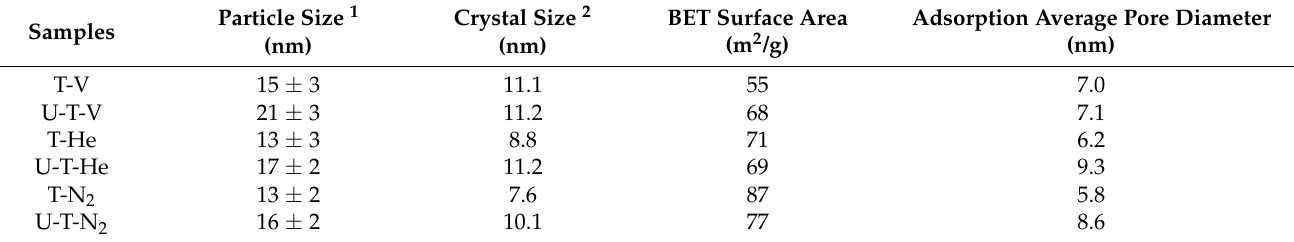
Table 1. Characteristics of the as-prepared TiO 2